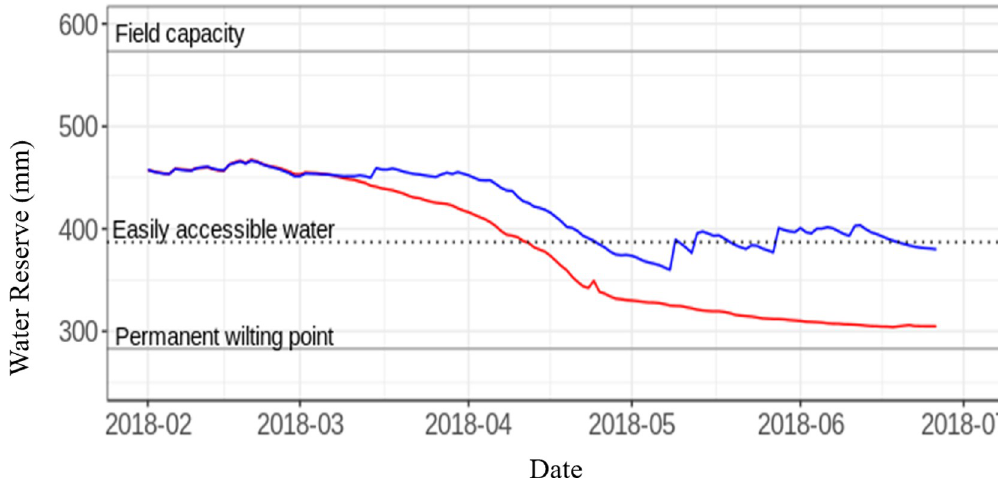
Fig 1. Dynamic of the cumulative rainfall from sowing and of the soil water reserve Pheno3C for the 2018 campaign, in the two treatments. Horizontal lines figure the soil water reserve (in mm) at Field Capacity Easily accessible water and permanent wilting point. Blue line is for plots under rainy conditions (not sheltered). Red line is for plots under controlled water deficit conditions (under shelter from the end of February).